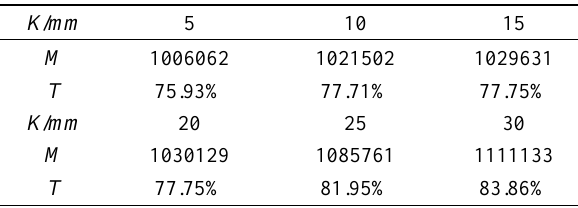
Table 3. Iterative filtering with different